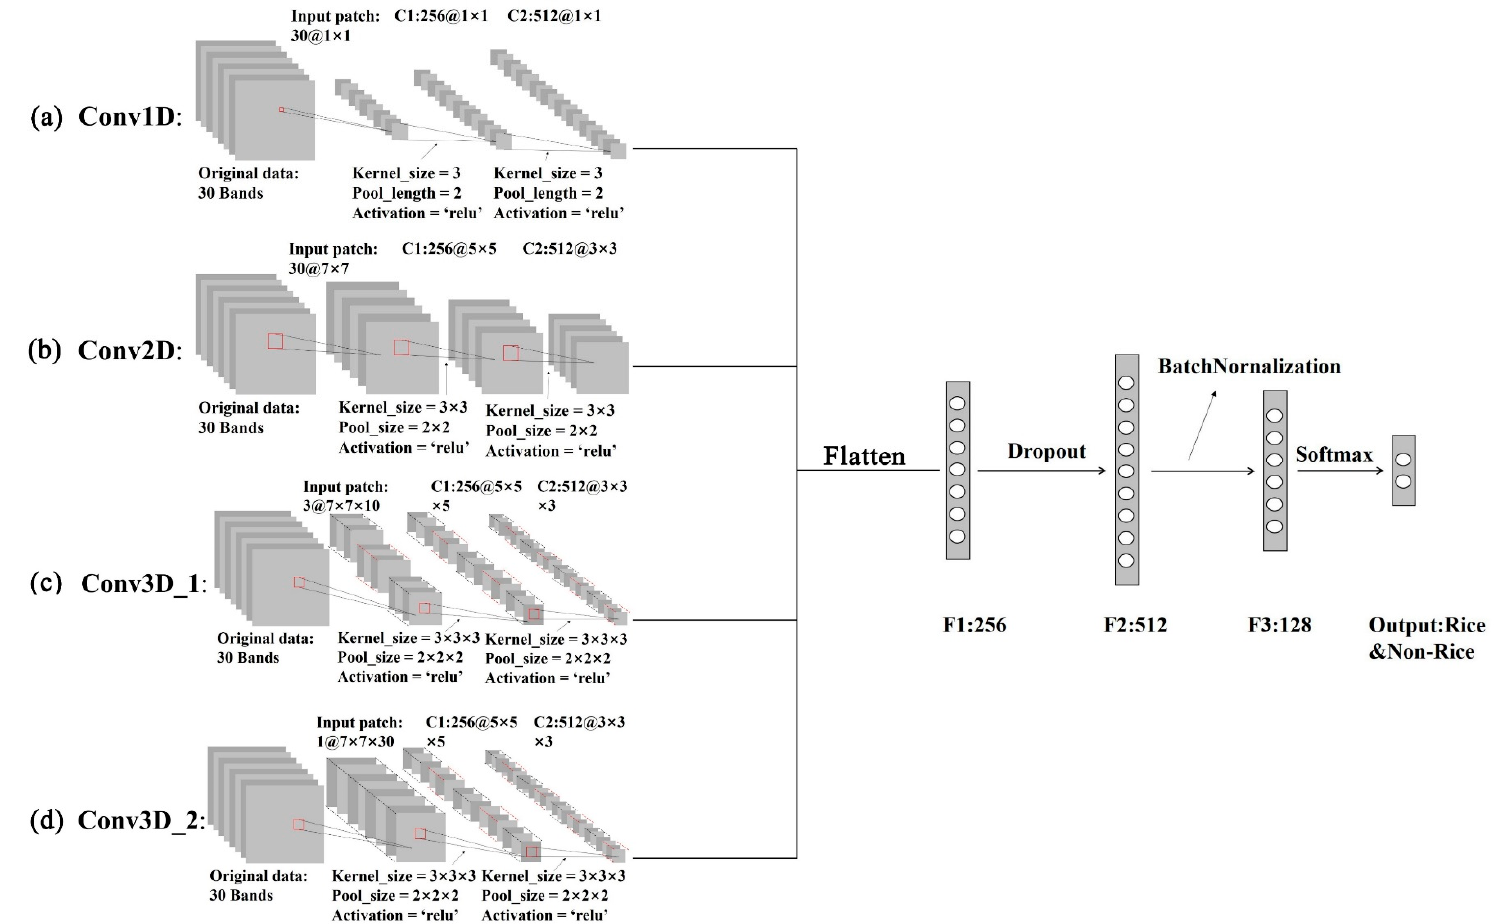
Figure 2. Network structure of Conv1D ( a ), Conv2D ( b ), Conv3D_1 ( c ) and Conv3D_2 ( d ). The input layer, fully connected layer and output layer of the four classifiers remain unchanged. Convolution kernels and pooling kernels have different dimensions, which vary according to the convolution dimensions. The parameters of convolutional neural networks (CNNs) are referenced at “https://keras.io/”.